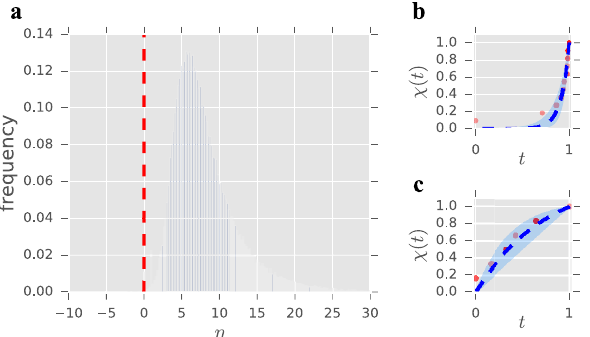
Figure 5. Summary of the results for the Facebook dataset. ( a ) Distribution of the parameter estimates for the Facebook dataset ( n = 98, 258 ). The red, dashed line marks the change of regime η = 0 ; mean = 8.25 , median = 7.17 , mode = 5.48 , std = 4.91 ( b ) Representative fitting for an individual exhibiting the standard regime (chosen at random from those with a strictly positive 95% confidence interval). Solid dots represent experimental data, blue dashed lines represent the graph of Eq. (9) with the corresponding estimated parameter, and shaded regions show the 95% confidence interval for that estimate (see “Bayesian estimate of the scaling parameter” section). Estimated η = 11.64 , 95% confidence interval (7.62, 17.79), ˜ L = 21 . ( c ) Example of fitting for an individual exhibiting the inverse regime (chosen at random from those with a strictly negative 95% confidence interval). Solid dots, blue dashed lines, and shaded regions have the same interpretation as in ( b ). Estimated η = − 1.34 , 95% confidence interval ( − 2.71, − 0.08 ) , ˜ L = 30 . See Fig. S7 in the Supplementary Information for a sample of 24 other fittings chosen randomly from the entire